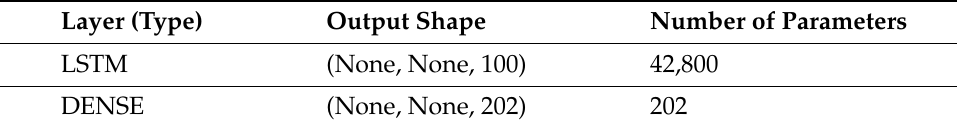
Table 2. Neural network architecture and number of